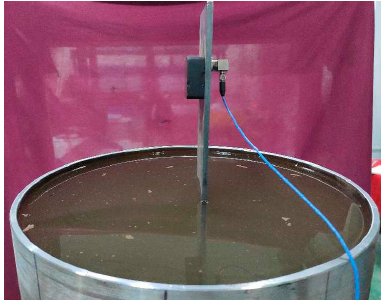
Figure 6. Experimental devices of the immersed cantilever.